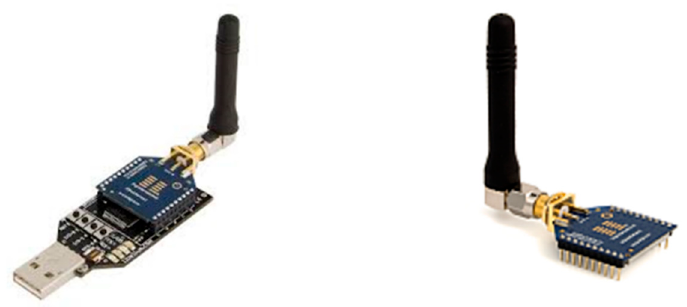
Figure 4. XBee RF Module and USB PC Gateway.